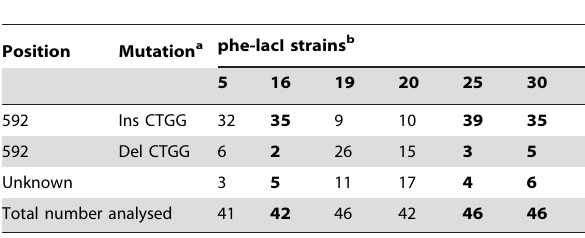
Table 4. Effect of the orientation of mutational target gene in the chromosome on occurrence of CTGG indels in P. putida strains carrying the phe-lacI test systems at various chromosomal